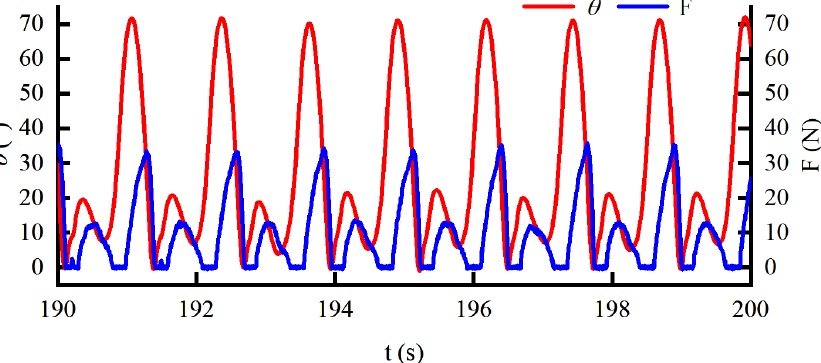
Figure 12. The dynamic curve for transparency detection under the HEIF in the outer loop and DOB in the inner loop during walking.